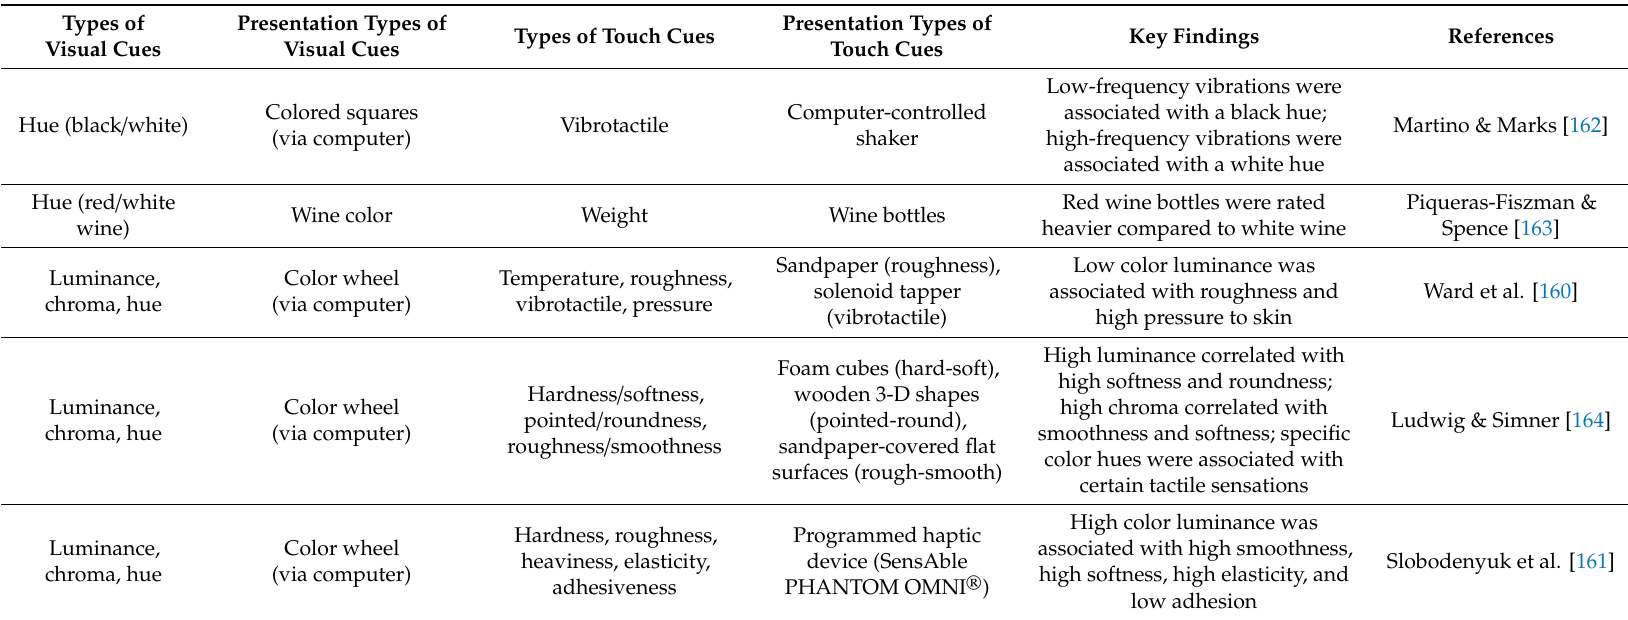
Table 1. The summary of findings regarding cross-modal associations between visual and hand-feel touch